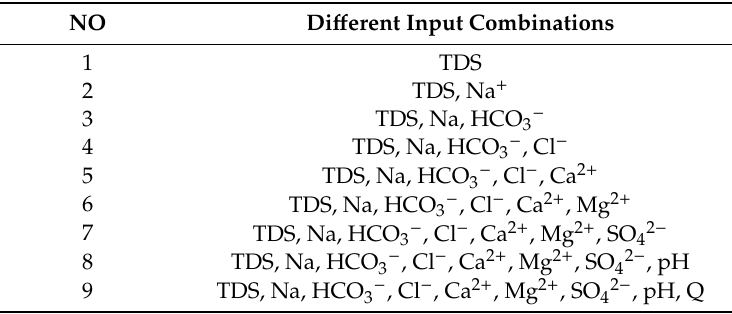
Table 3. Various input combinations used in the